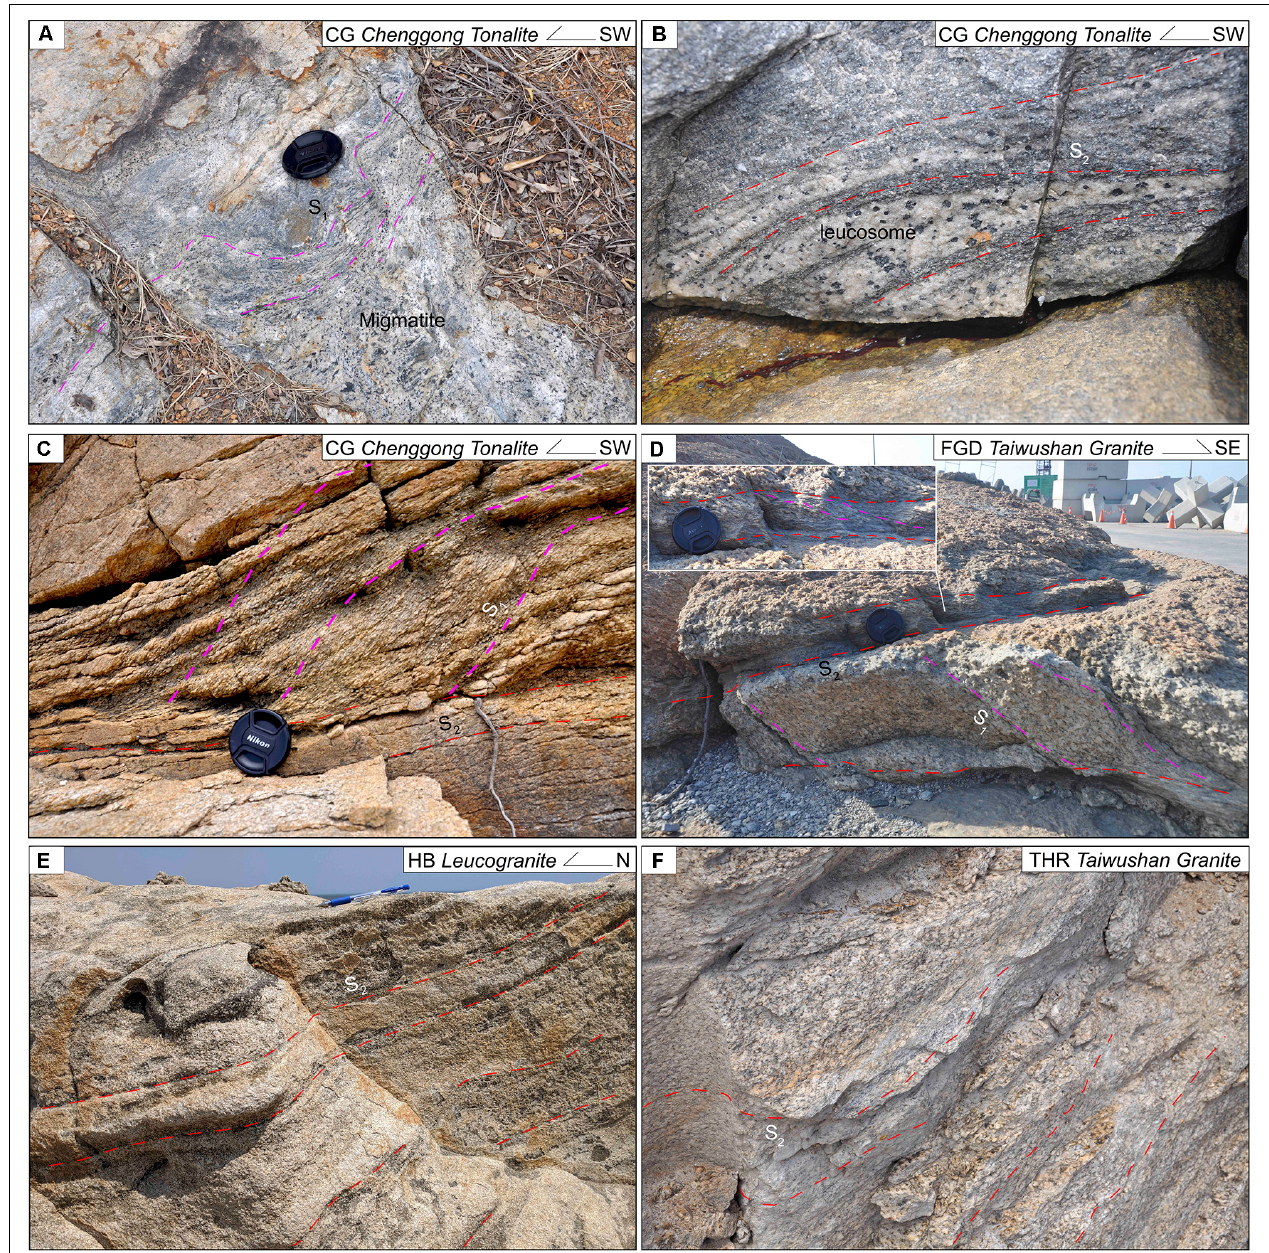
FIGURE 6 | Outcrop photos and sketches showing interpreted structures of D 1 and D 2 . (A) In situ migmatite developed along the S 1 gneissic foliation within Chenggong Tonalite at CG. (B) S 2 -folded leucosome in Chenggong Tonalite indicates that the migmatitic condition is confined in D 1 domain at CG. (C) Wavy S 1 foliation due to the development of subhorizontal S 2 foliation at CG. (D) Subhorizontal S 2 foliation crosscuts the S 1 doming fabric in Taiwushan Granite at FGD. (E) Subhorizontal S 2 foliation developed within the leucogranite showing the pre-D 2 magmatic intrusion at HB. (F) Subhorizontal S 2 foliation (S-tectonite) developed in Taiwushan Granite at THR.